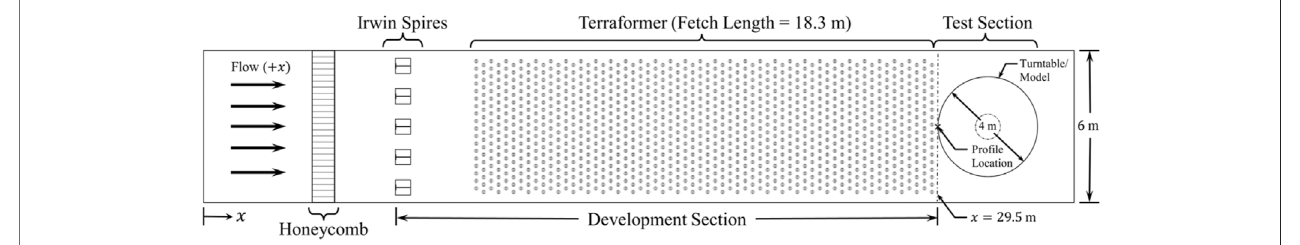
FIGURE 3 | Boundary Layer Wind Tunnel Con fi guration.